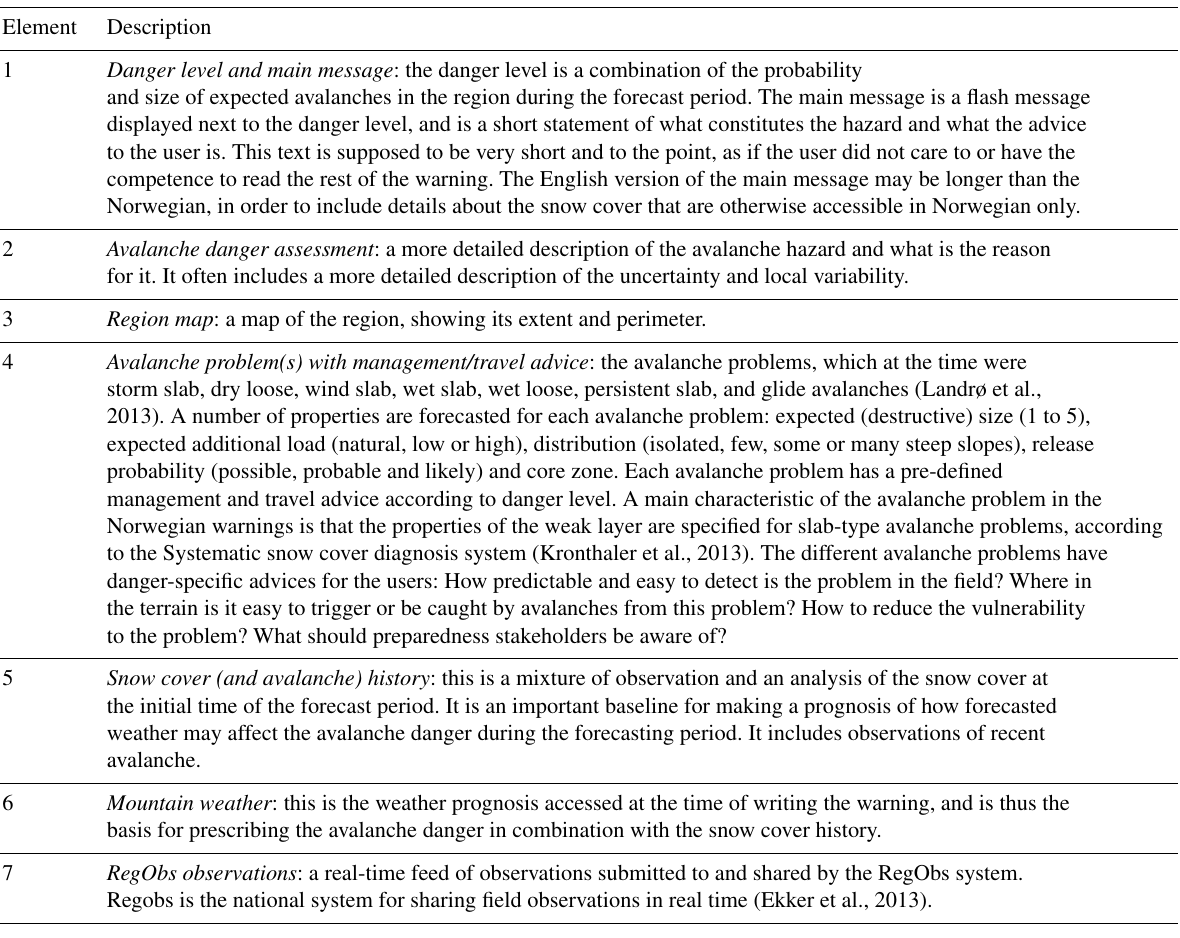
Table 1. A description of the elements included in the avalanche warning on Varsom.no. Figure 2 shows how the elements are shown in relation to each other on a smartphone web